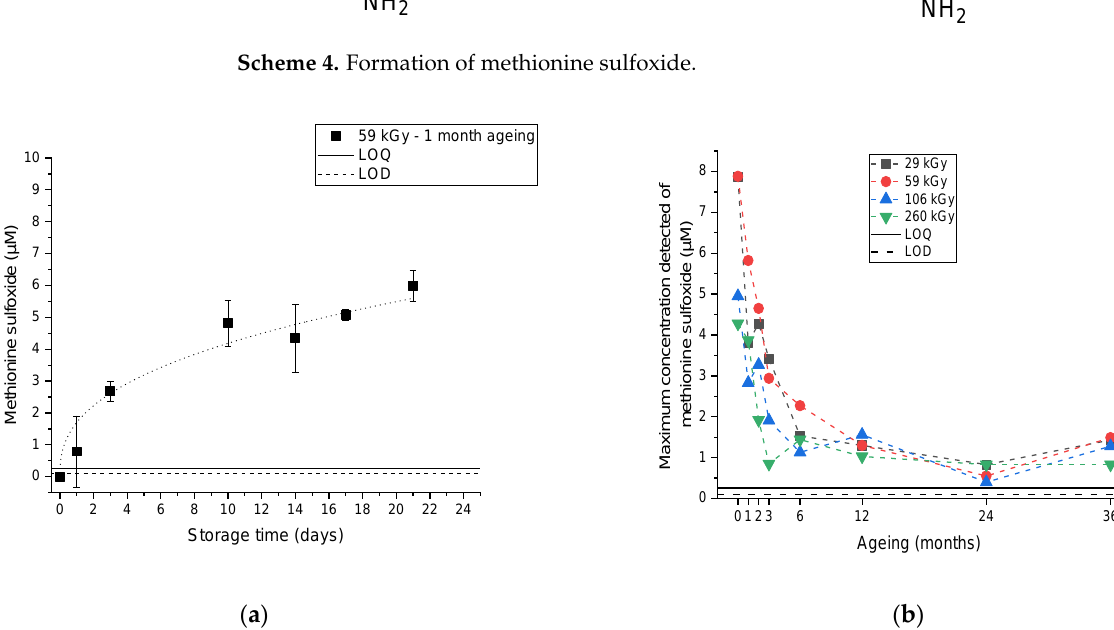
Figure 7. ( a ) Concentration in methionine sulfoxide vs storage time at room temperature for one-month aged bag irradi- ated at 59 kGy containing a solution of water (methionine = 50µM). ( b ) Plots of maximum of concentration in methionine sulfoxideF after 21 days of storage vs ageing of bag after irradiation at various doses. LOQ for limit of quantification and LOD for limit of detection. Reproduced from [42] with the permission of Polymers.